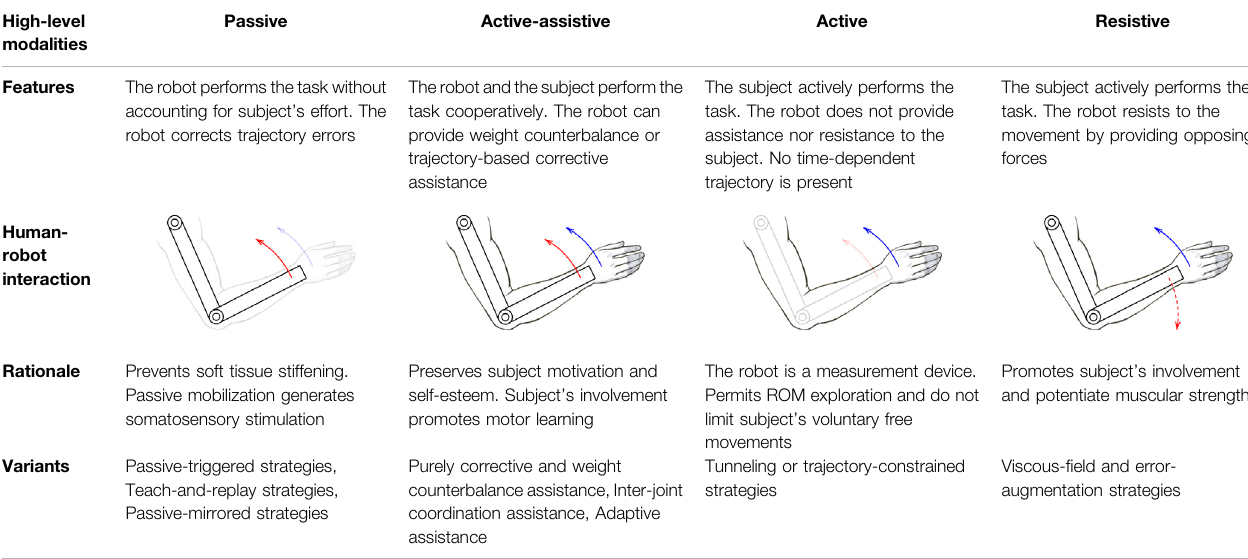
TABLE 2 | High-level training modalities for upper-limb robot-mediated rehabilitation. Classi fi cation refers to subject ’ s status at interaction. Red arrows represent exoskeleton assistance (solid) or resistance (dashed). Blue arrows indicate user voluntary effort, if present. High-level